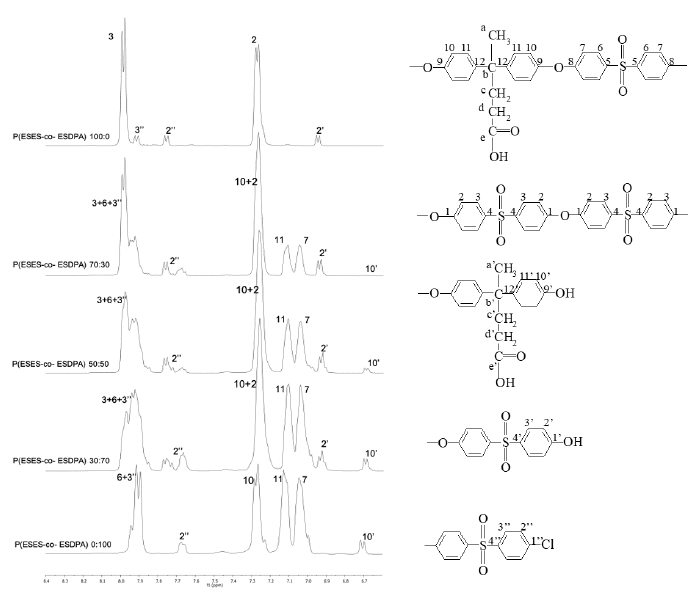
Figure 2. 1 H-NMR spectra in the aromatic region between 6.4 and 8.4 ppm of five polymer samples.